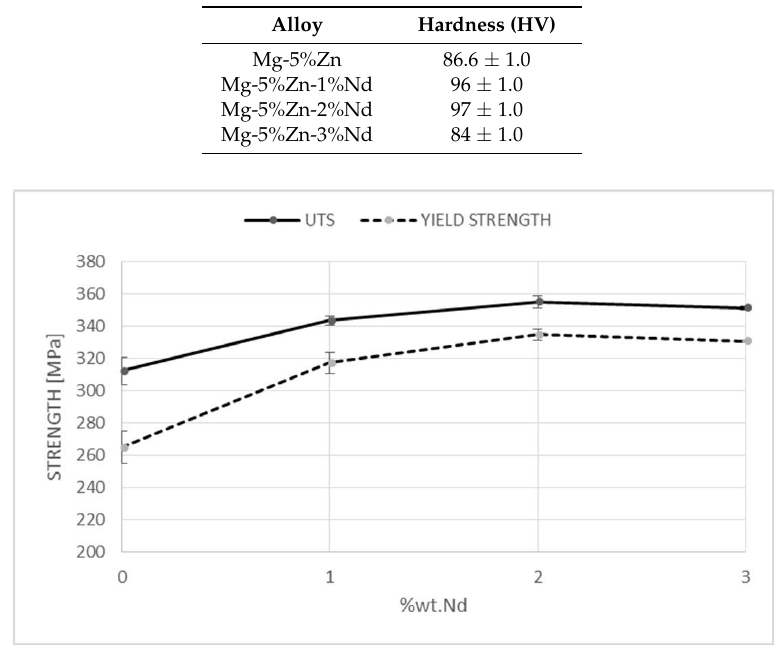
Figure 5. Ultimate tensile strength (UTS) and Yield strength (YS) of tested alloys vs. Nd content. Metals 2018 , 8 , x FOR PEER REVIEW